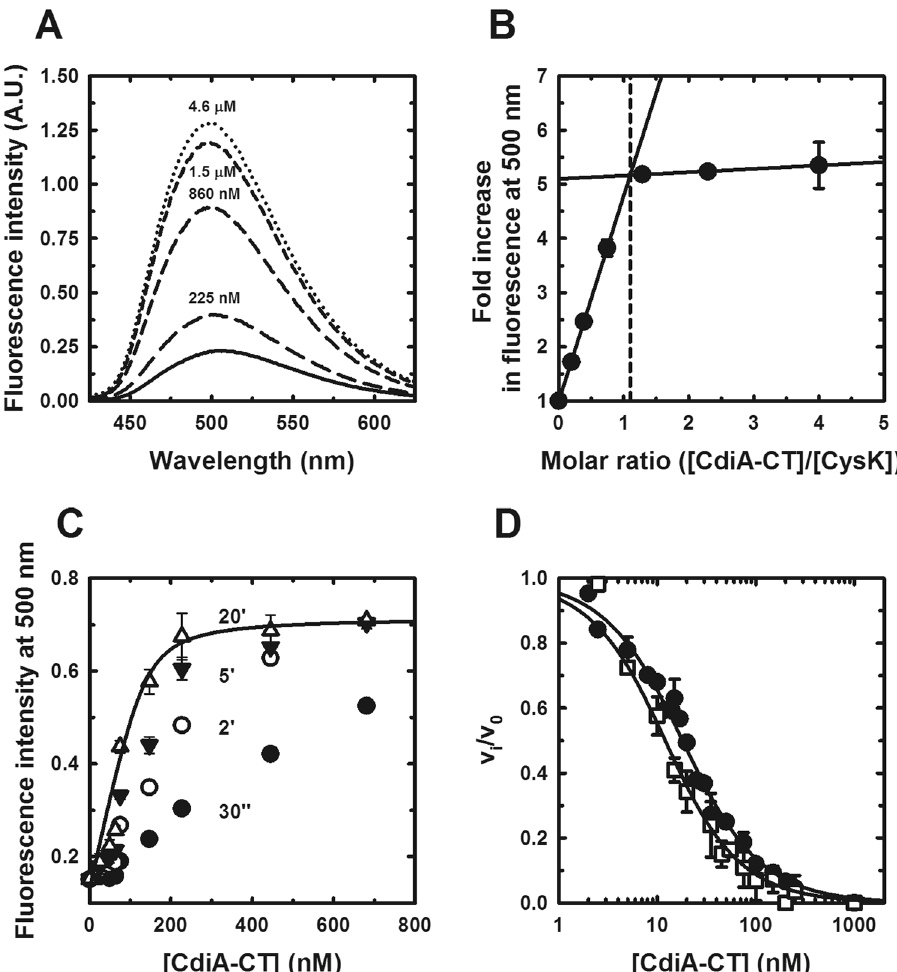
Figure 1. EcCysK:CdiA-CT complex formation. ( A ) Fluorescence emission spectra of EcCysK excited at 412 nm. Spectra were collected with EcCysK (1.15 µ M) in the presence of the indicated concentrations of CdiA-CT. ( B ) Stoichiometry of the EcCysK:CdiA-CT complex. 1 μ M EcCysK was titrated with CdiA-CT to saturation. The intersection of the lines corresponds to a CdiA-CT:EcCysK ratio of 1.1:1 (dashed line). ( C ) Determination of the EcCysK:CdiA-CT dissociation constant. EcCysK (80 nM) was titrated with increasing concentrations of CdiA-CT, and fluorescence emission at 500 nm monitored at the indicated times. The solid line indicates the Eq. 2 fit to the 20 min data set, with K d = 10 ± 11 nM and [CysK] = 134 ± 33 nM. ( D ) CdiA-CT inhibits EcCysK sulfhydrylase activity. EcCysK (6 nM) was titrated with CdiA-CT and sulfhydrylase activity measured as described in the Methods. Eq. 3 was fitted to the dependence of v i /v 0 on CdiA-CT concentration, yielding an apparent IC 50 that was used to calculate a K i of 11.0 ± 0.4 nM (closed circles). A K i of 6.4 ± 0.5 nM was calculated under the same conditions in the presence of 2.4 µ M CdiI (open